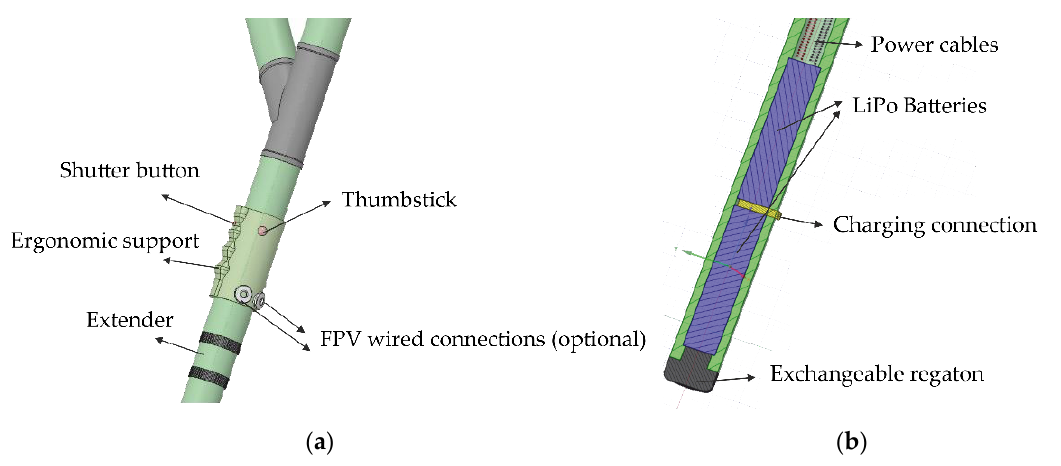
Figure 2. Detail and mechanisms of ( a ) the control system and ( b ) the bottom of the device where the power system is located.